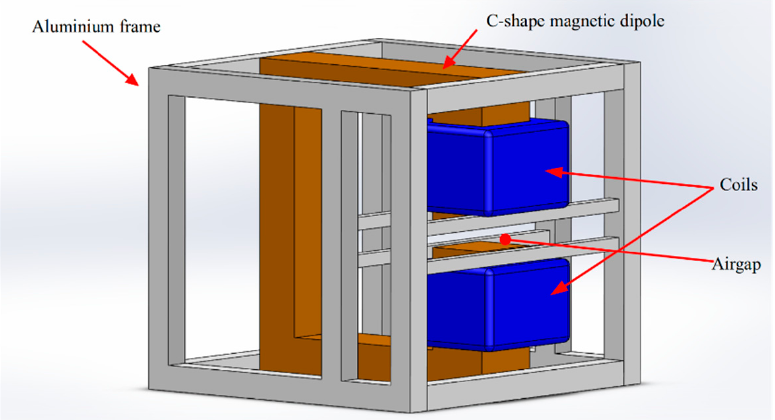
Figure A1. Electromagnet setup used for the production of foams with aligned particles. The magnetic field homogeneity in the airgap was preliminary checked in 16 points, evenly spaced in the electromagnet airgap section. A transverse Hall probe (model HMMT- 6J04-VR, Lake Shore Cryotronics, Inc., Westerville, OH, USA) and a gaussmeter (model DSP 475, Lake Shore Cryotronics, Inc., Westerville, OH, USA) were used to measure the actual magnetic field. In Figure A2, we report the scattered measured data (grey data points) and an interpolated three-dimensional surface. The results show that the magnetic field intensity in the gap was almost homogeneous, with a variance lower than